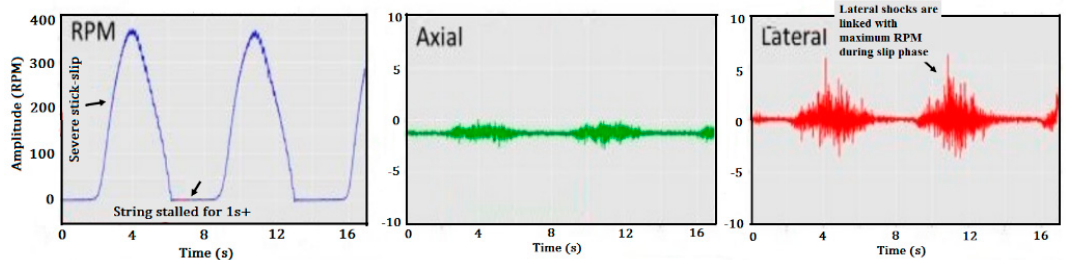
Figure 5. Measured vibration using BlackBox in Well-1.